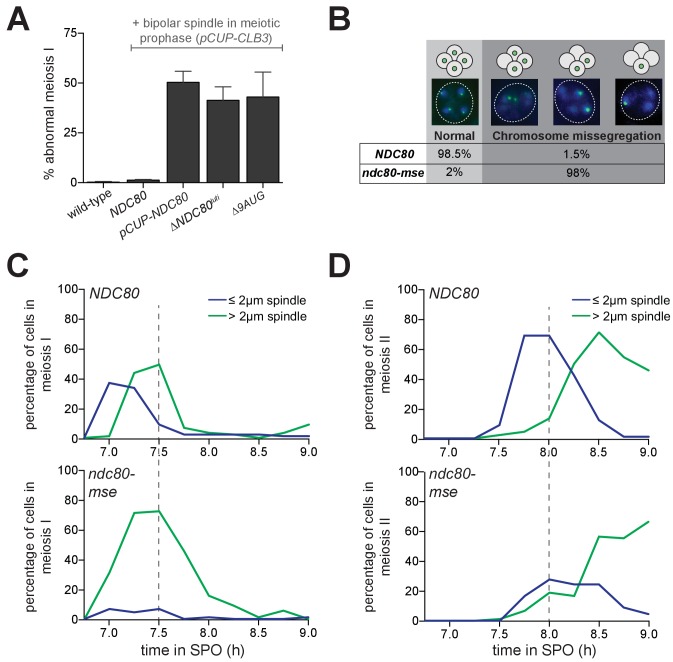
Temporal regulation of Ndc80 level by NDC80luti and NDC80ORF in meiosis is required for proper meiotic chromosome segregation.(A) Sister chromatid segregation in wild type (UB2942), pCUP-CLB3 (UB877), pCUP-CLB3 pCUP-NDC80 (UB880), pCUP-CLB3 ∆NDC80luti (UB2940), and pCUP-CLB3 ∆9AUG (UB2936) cells. Cells were induced to sporulate by transferring to SPO, and 6 hr later, expression of the cyclin Clb3 was induced by addition of CuSO4. Immediately after induction, cells were released from pachytene by addition of β-estradiol. Samples were taken 1 hr 45 min after the release. Premature segregation of sister chromatids in meiosis I (abnormal meiosis I) was detected as two separated GFP dots in binucleates, one in each nucleus. The average fraction of binucleates that displayed sister segregation in meiosis I from three independent experiments, as well as the standard error of the mean, was graphed. 100 cells were counted per strain, per experiment. (B) Chromosome segregation accuracy in wild type (UB5876) and ndc80-mse (UB5437) strains was determined by counting homozygous CENV-GFP dots in tetranucleates. Samples were taken 7.5 hr after transfer to SPO when most cells had completed meiosis in an asynchronous system. The fraction of tetranucleates that displayed normal segregation (one GFP dot in each nucleus), or missegregation (multiple or zero GFP dots in any of the four nuclei) was quantified. The average fraction of normal segregation or missegregation from two independent experiments is shown. Over 100 cells were counted per strain, per experiment. (C–D) Percentage of wild type (UB4074) and ndc80-mse (UB3392) cells with meiosis I spindles (shown in C) or meiosis II spindles (shown in D) that were longer than 2 μm, as well as the percentage of cells with spindles that were shorter than 2 μm. Both strains harbor the pGAL-NDT80 GAL4-ER system. After 6 hr in SPO, the cells were released from pachytene by addition of β-estradiol, and samples were taken every 15 min after the release. Over 100 cells per time point were quantified, and the results of one representative repeat from two independent experiments are shown.